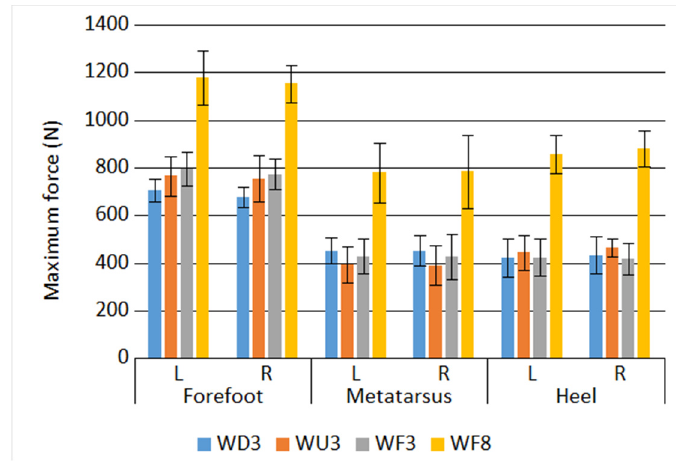
Figure 14. Maximum force generated during selected physical activities.